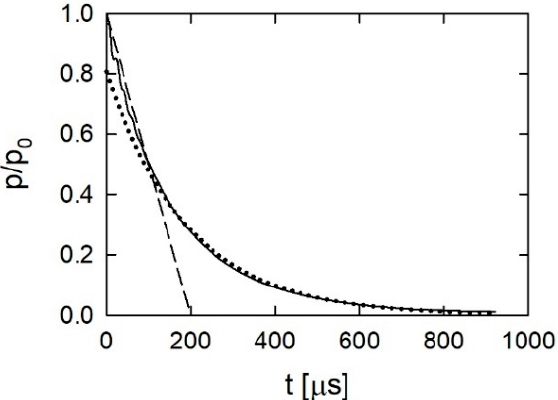
Figure 14. The changes in time of the average pressure acting on the primer bottom (solid line); exponential approximation (dotted line); linear approximation of the initial part of the plot (dashed line).